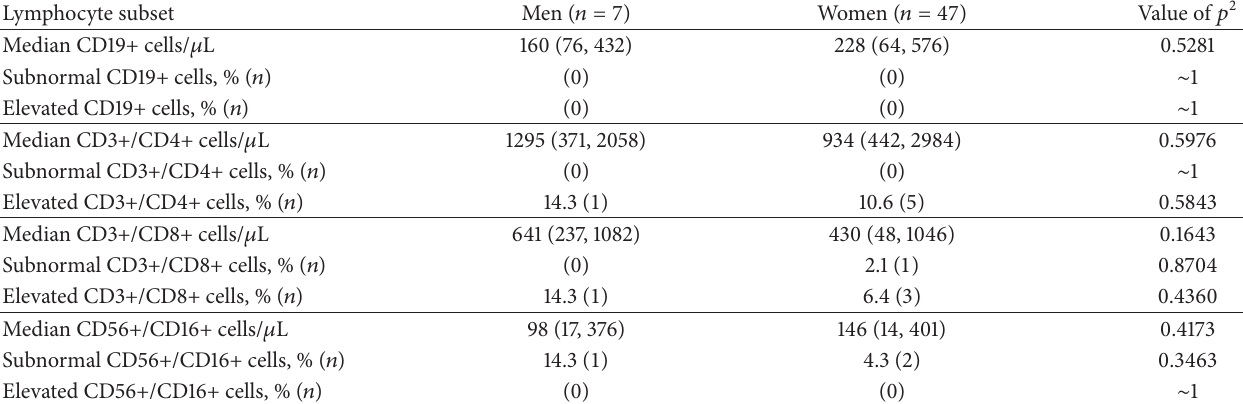
Table 2: Blood lymphocyte subsets in 54 adults with selective subnormal IgG1 1